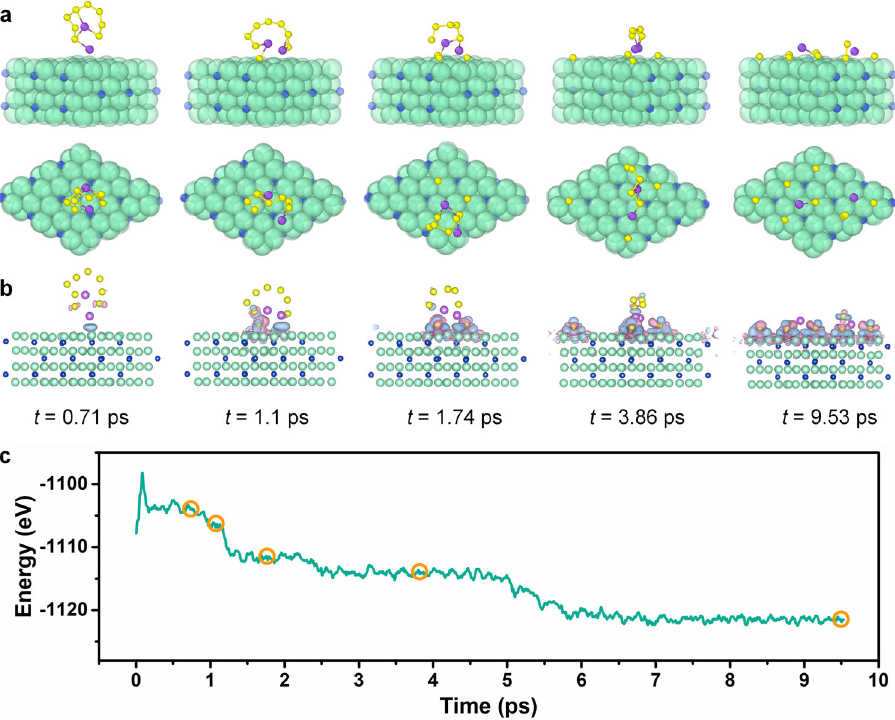
Fig. 4 Theoretical analysis of the Na 2 S 8 dissociative adsorption process. Structure ( a ), differential charge density ( b ), and potential energy ( c ) evolution of Na 2 S 8 -Fe 3 N as a function of AIMD simulation time. Blue/red isosurfaces in ( b ) represent electron accumulation/depletion regions, respectively. Isosurface scale level is set to 0.02 e/Å 3